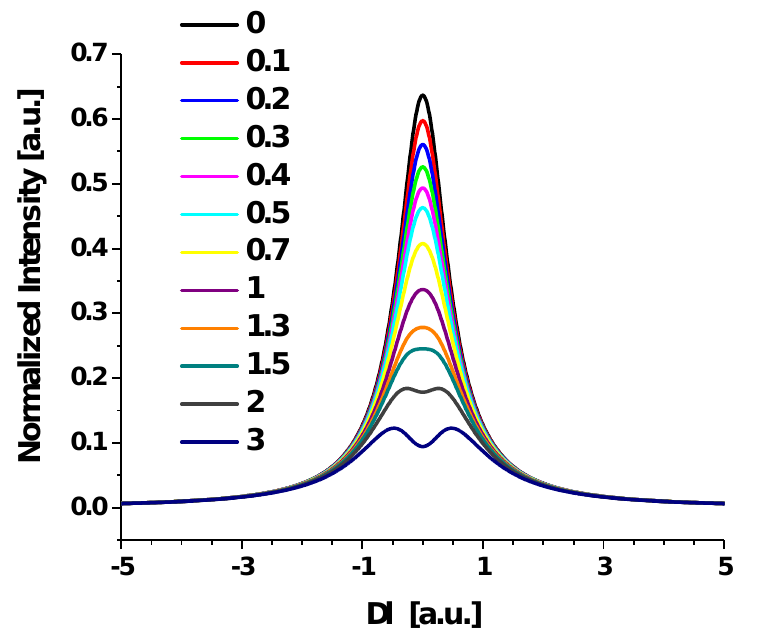
Figure 1. Alterations of a Lorentzian line profile under the influence of self-absorption for increasing optical density. The undistorted line width is 1